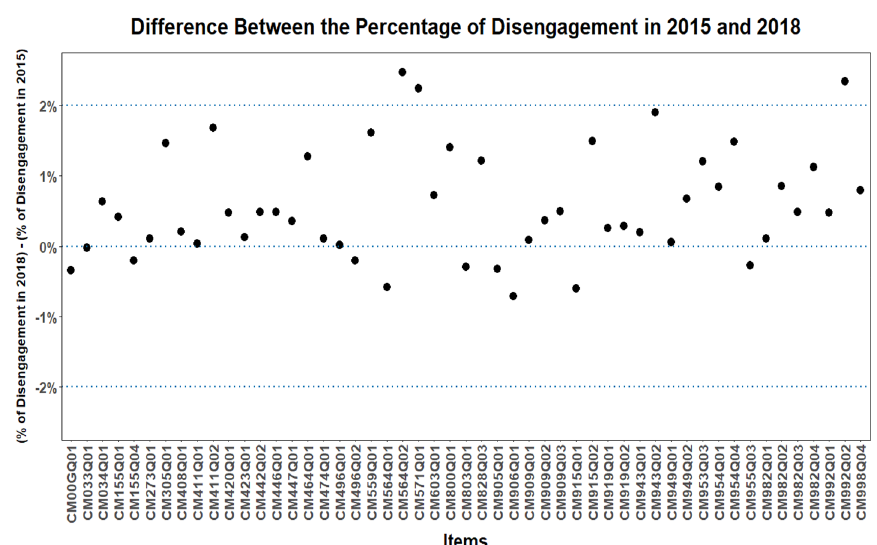
Fig. 2 Difference between the percentage of disengagement in 2015 and 2018. The difference is the percentage of disengagement in 2015 subtracted from the percentage in 2018. Source : Organisation for Economic Co-operation and Development (OECD), Programme for International Student Assessment (PISA), 2015 and 2018 Mathematics Assessment